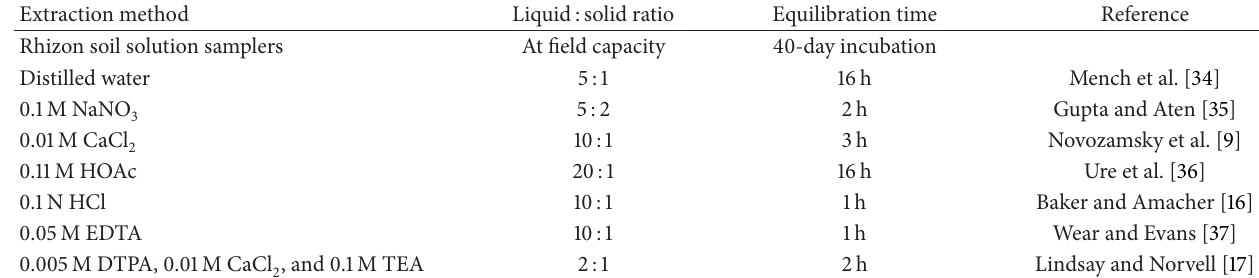
Table 2: Single extraction procedures